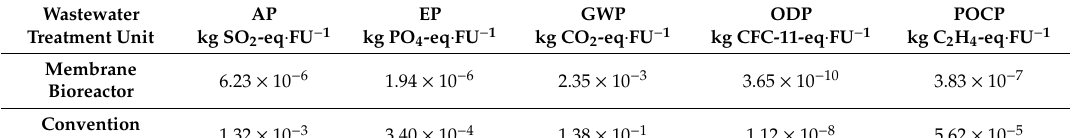
Table 5. LCIA with no wastewater treatment plant life cycle contribution.